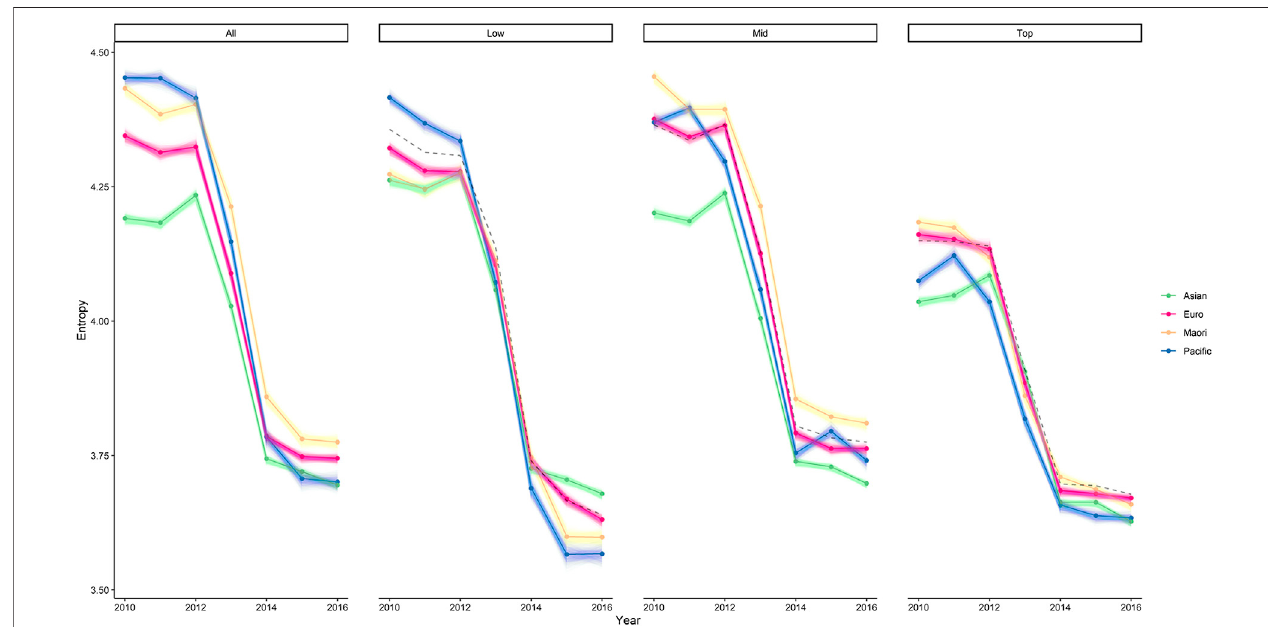
FIGURE 8 | Entropy by School Decile Across Years. The entropy of each ethnic group sub-population, split by high school decile. The baseline entropy (black dotted line) is lower for the top decile schools (deciles 7 – 10), and higher for the low decile schools (deciles 1 to 3). There are observable differences in entropy in each decile.Priorto2013,theoverallentropytendedtobehigherforM (cid:2) aoriandPaci fi csub-populations,andlowerforAsianandEuropean.Afterthepolicyreform,thispattern seemingly changed such that the Paci fi c sub-population had the lowest